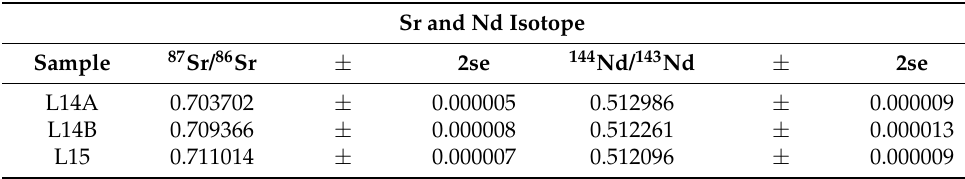
Table 3. Sr and Nd isotopes of samples L14A, L14B, and L15.